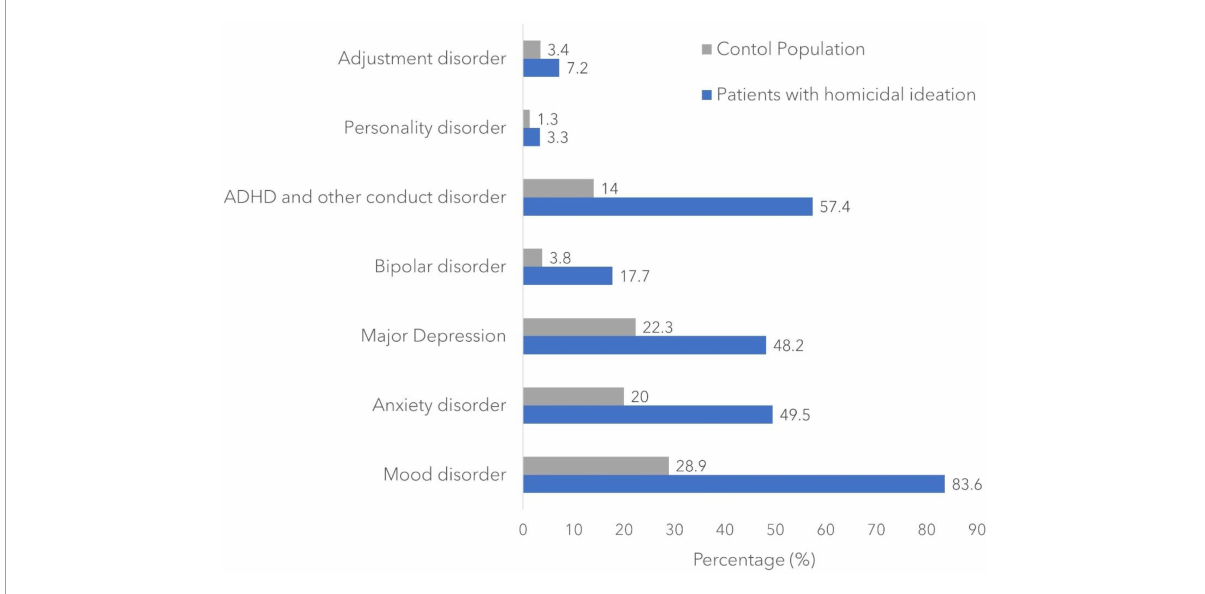
FIGURE1 Incidence rate of psychiatric comorbidities among the study